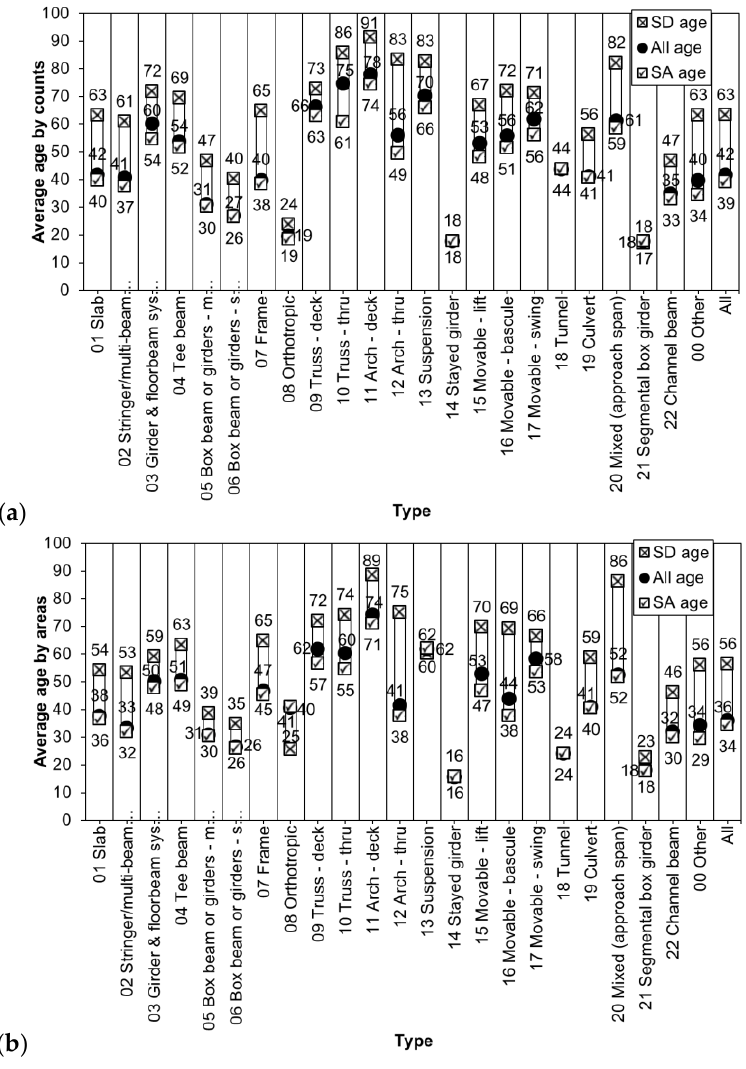
Figure 9. Average ages of bridges. (a) Counts and (b) Areas.